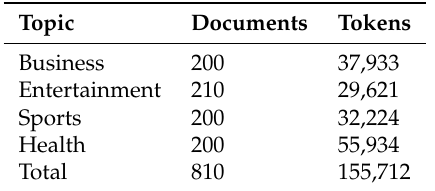
Table 2. Detail of Dataset without overlapping.